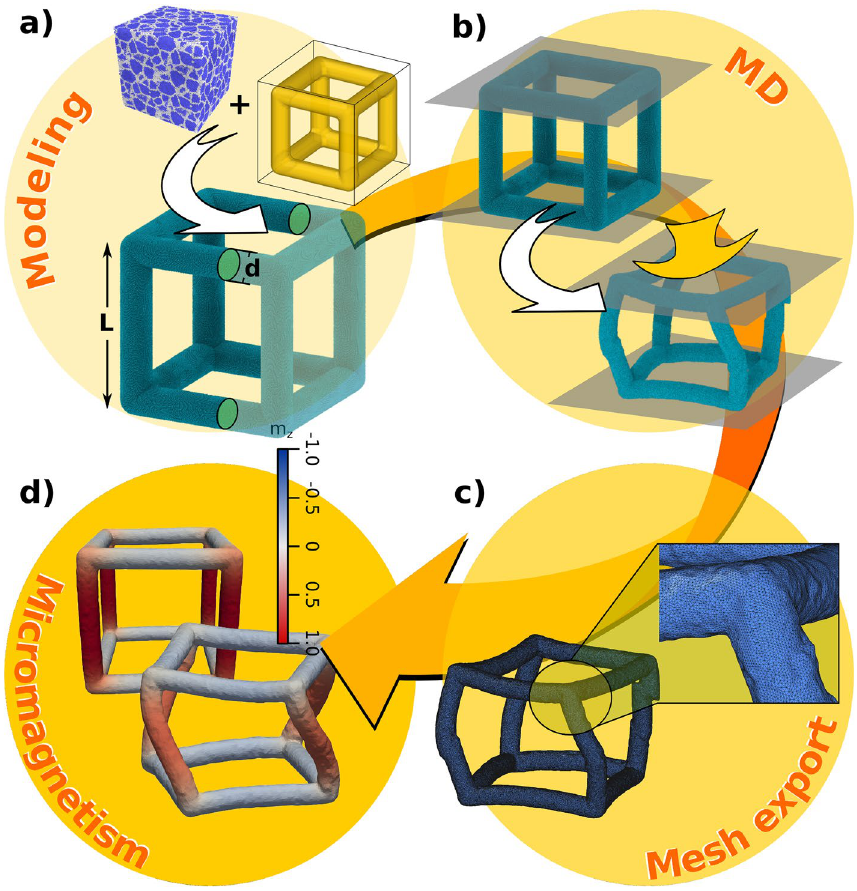
Figure 7. Schematic of methodology to combine ( a ) atomistic designed structures that were ( b ) compressed using molecular dynamics. Then result surface meshes are ( c ) exported to compute ( d ) micromagnetic